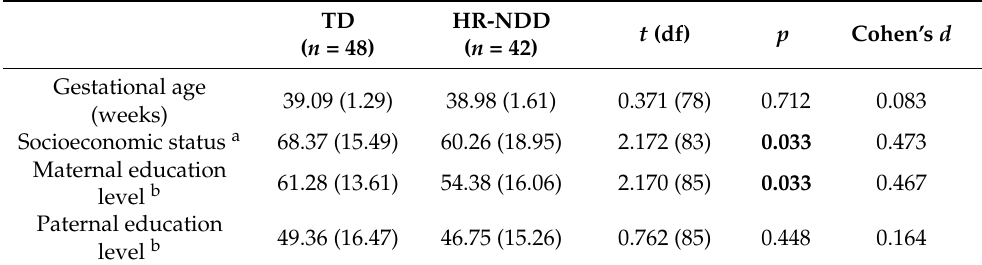
Table 1. Descriptive statistics: Mean (Standard Deviation) and group comparisons on individual and socio-demographic variables.